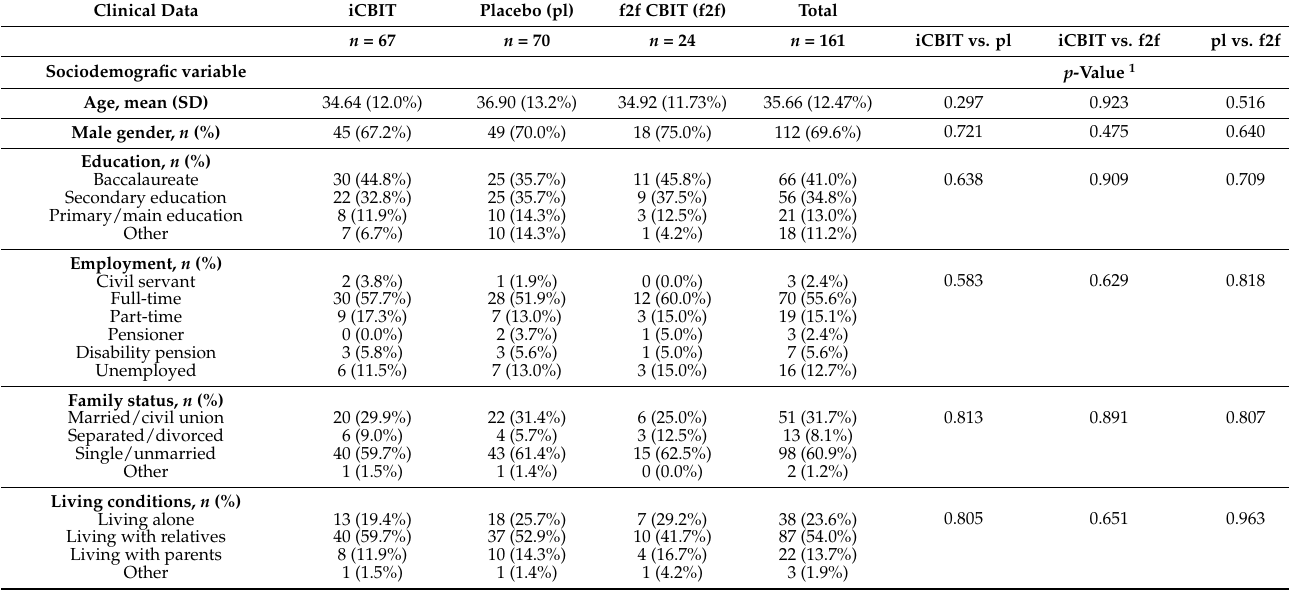
Table 1. Baseline characteristic: socio-demographic variables.